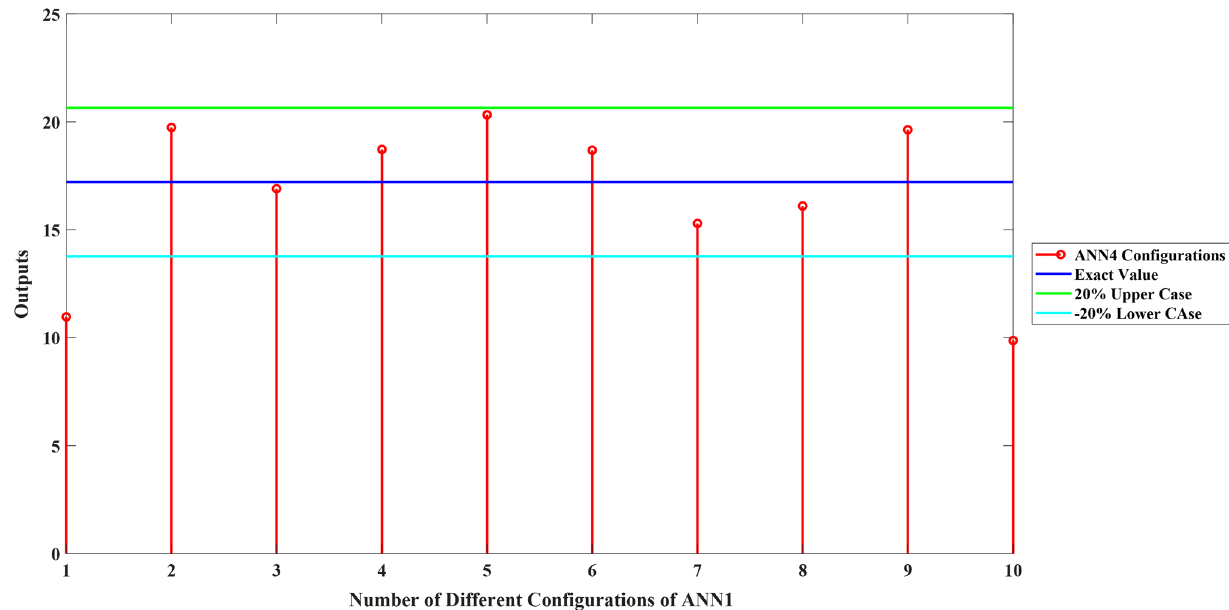
Fig. 30 The performance evaluation of the Model No. 4 (ANN 4) with different configurations Table 7 Characteristics of the SPTNo. additional boreholes